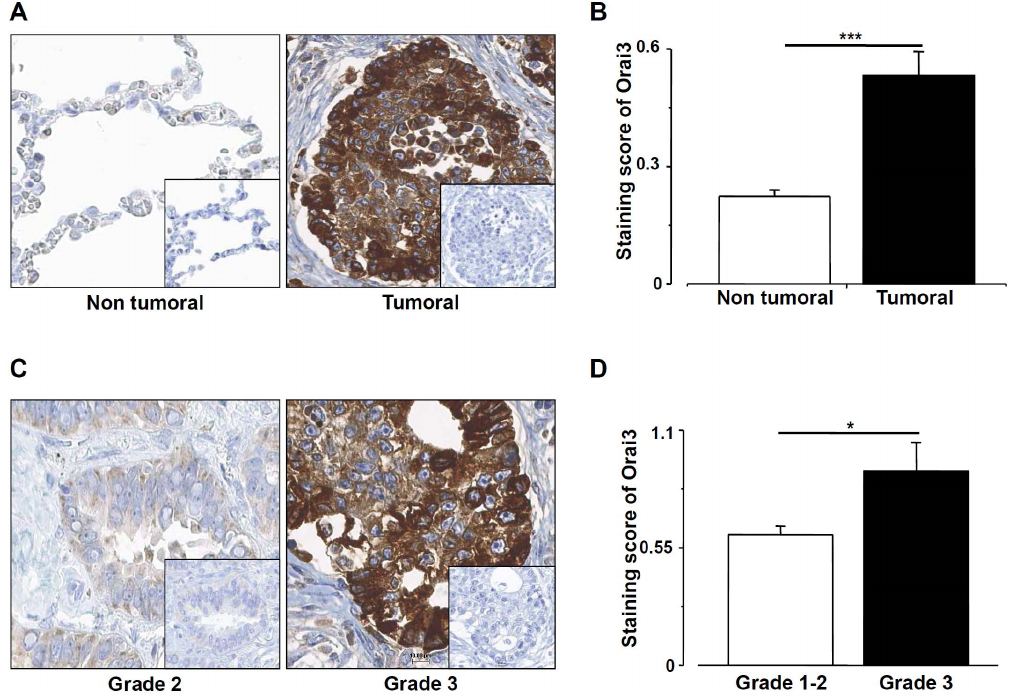
Figure 1. Orai3 is overexpressed in lung adenocarcinoma and correlated with high tumor grade. A: Representative examples of Orai3 expression in cancerous and matched non-tumoral human lung tissues, as assessed by immunohistochemistry. Original magnification: 6 400. Insert negative control obtained by omitting the primary antibody. B, quantitative analysis of Orai3 staining score in tumoral and adjacent non-tumoral lung tissue (n=60, *** p , 0.001, Mann-Withney test). C, Typical examples of Orai3 immunoreactivity in grade 2 lung cancer tissue (weak staining) and in grade 3 lung adenocarcinoma tissue (strong staining) at a magnification of 6 400. Inserts negative control obtained by omitting the primary antibody. D, quantification of Orai3 staining score in grade 1–2 versus grade 3 lung cancer (n=40, p =0.032, Mann-Withney